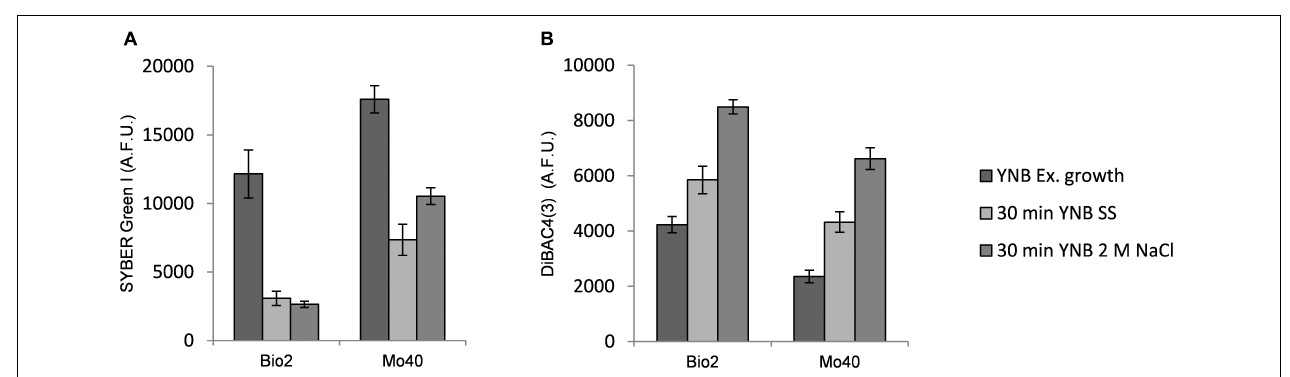
and of 83 and 180% in Mo40 cells exposed to SS and 2 M NaCl, respectively ( Figure 3B